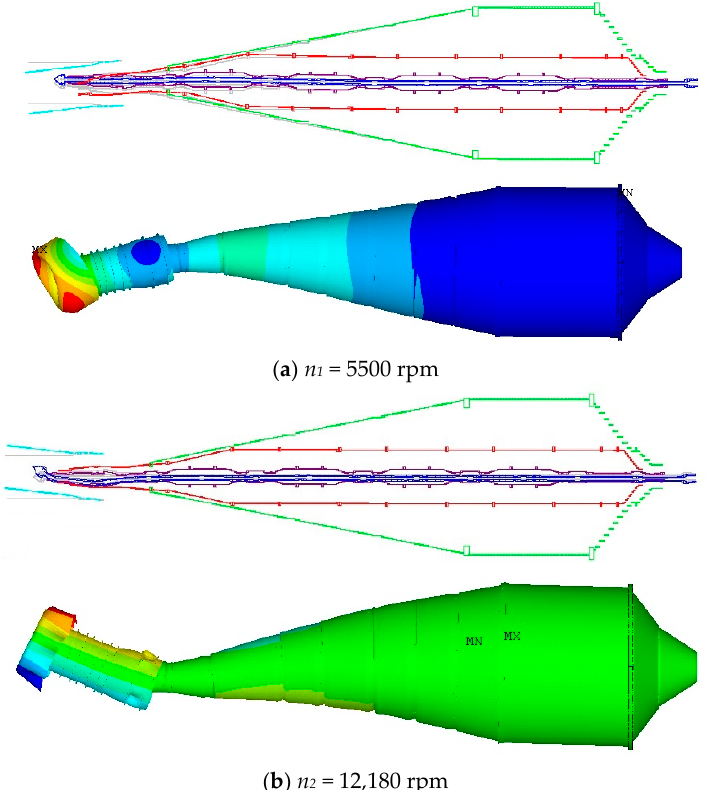
Figure 5. Comparison of calculated data for two vibration modes with ( a ) n 1 = 5500 rpm and ( b ) n 2 = 12,180 rpm using the simplified beam model found by the Central Institute of Aviation Motors’ (CIAM) software package and by ANSYS software for the rotor–casing system with a nacelle installed in the cantilever part of the casing.